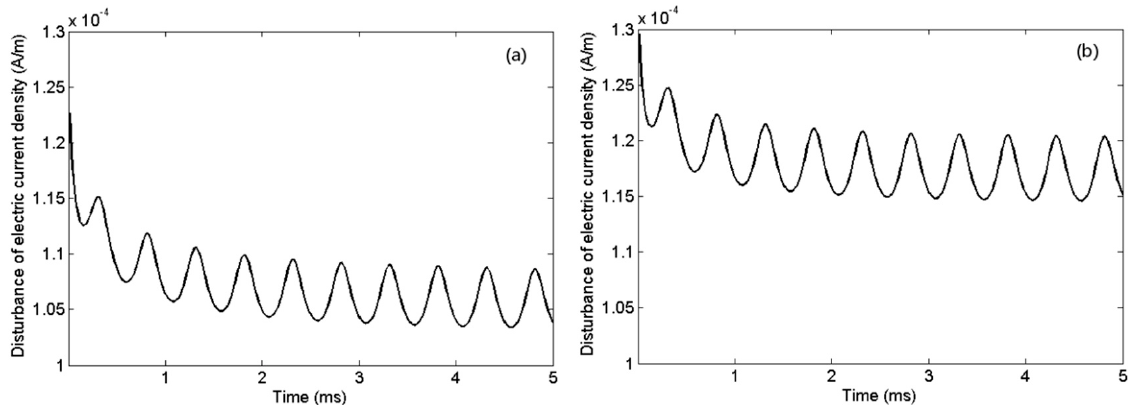
Figure 7. Disturbances of electric current density over time during BW with a modulated frequency f = 2000 Hz ( a ) without and ( b ) after preheating.